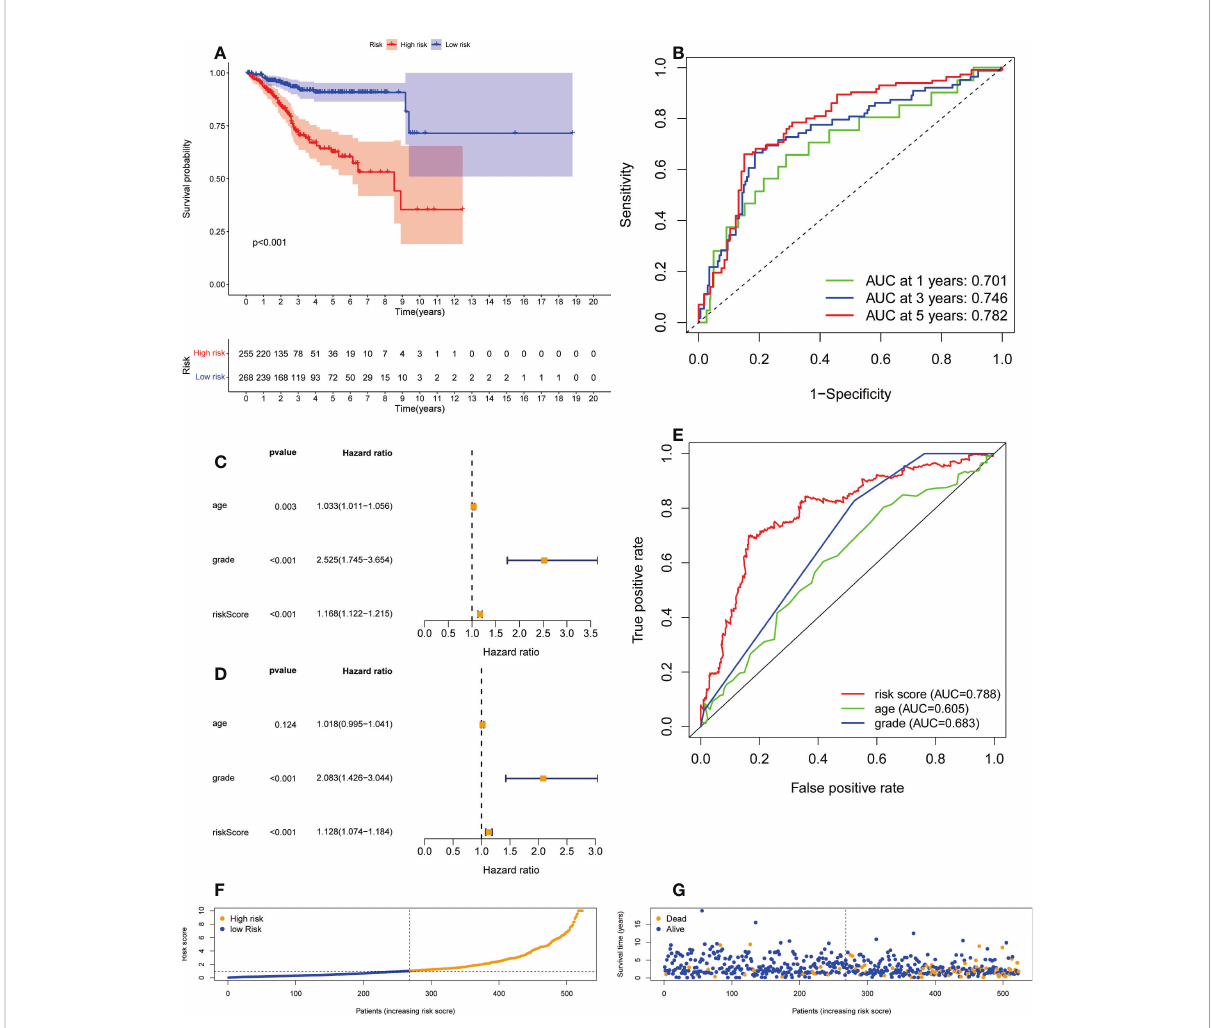
FIGURE 3 The correlation between the predictive signature and the prognosis of UCEC patients. (A) Kaplan-Meier analysis of the OS rate of UCEC patients between the high and low-risk groups. (B) The ROC curve and AUCs at one-year, three-years and fi ve-years survival for the predictive signature. (C) Forest plot for univariate Cox regression analysis. (D) Forest plot for multivariate Cox regression analysis. (E) The ROC curve and AUCs of the risk score, age and grade. (F) The number of dead and alive patients with different risk scores. Blue represents the number of alive, and yellow represents the number of dead. (G) The distribution of the risk score in UCEC patients. UCEC, Uterine Corpus Endometrial Carcinoma; OS, overall survival; ROC, receiver operating curve; AUC, area under the